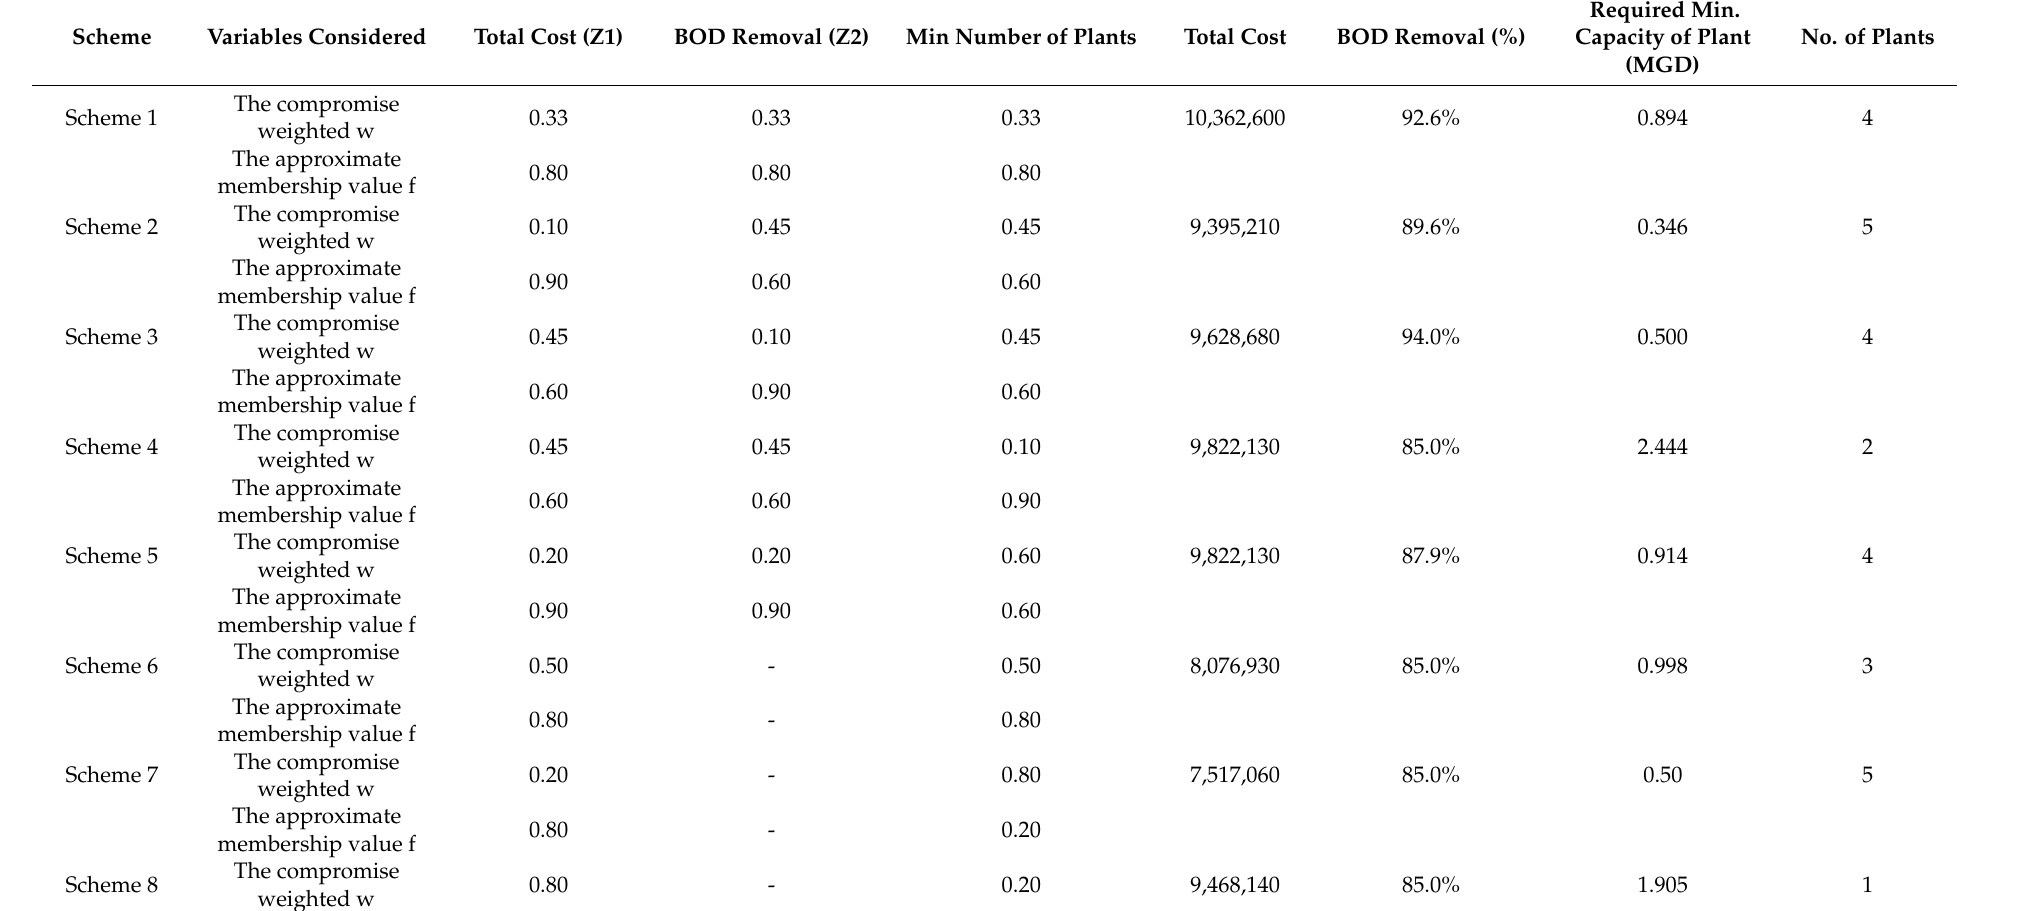
Table 2. Results for five schemes involving the consideration of three or two